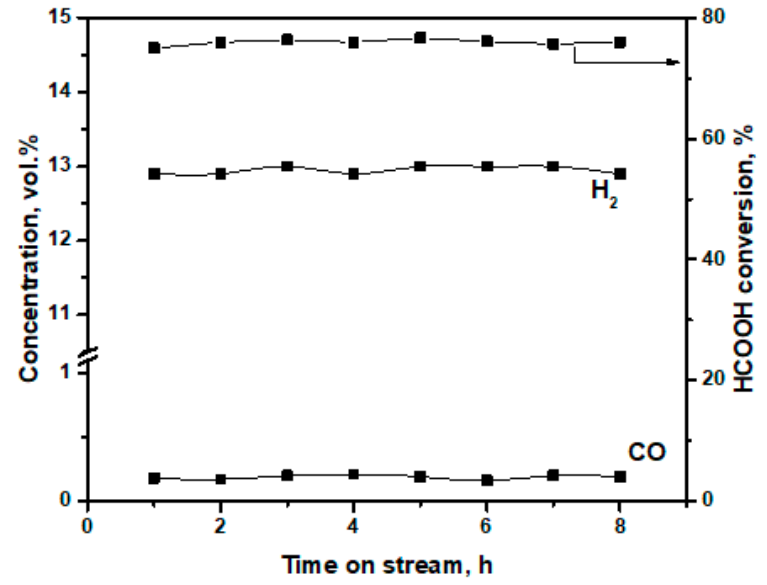
Figure 6. Effect of time on stream on CO and hydrogen outlet concentrations in FA decomposition over CuO-CeO 2 / γ -Al 2 O 3 catalyst. Reaction conditions: p = 1 atm, T = 250 °C, GHSV= 35,000 h − 1 ; Inlet composition, vol.%: N 2 :HCOOH = 75:25.